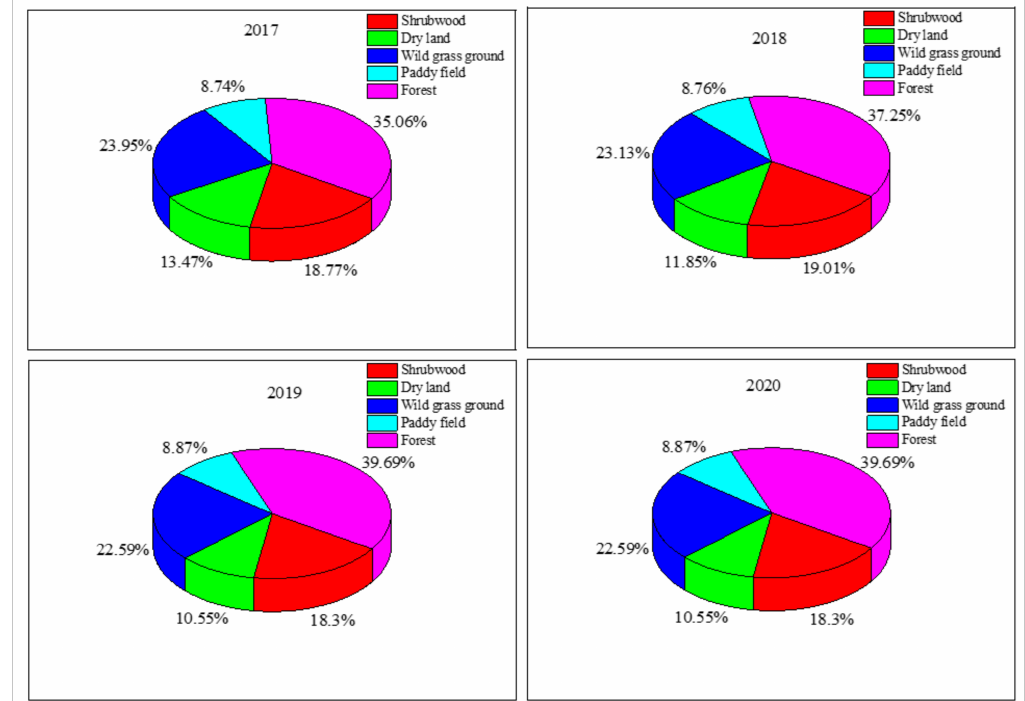
Figure 5. Proportion of land types in the Longchuan river